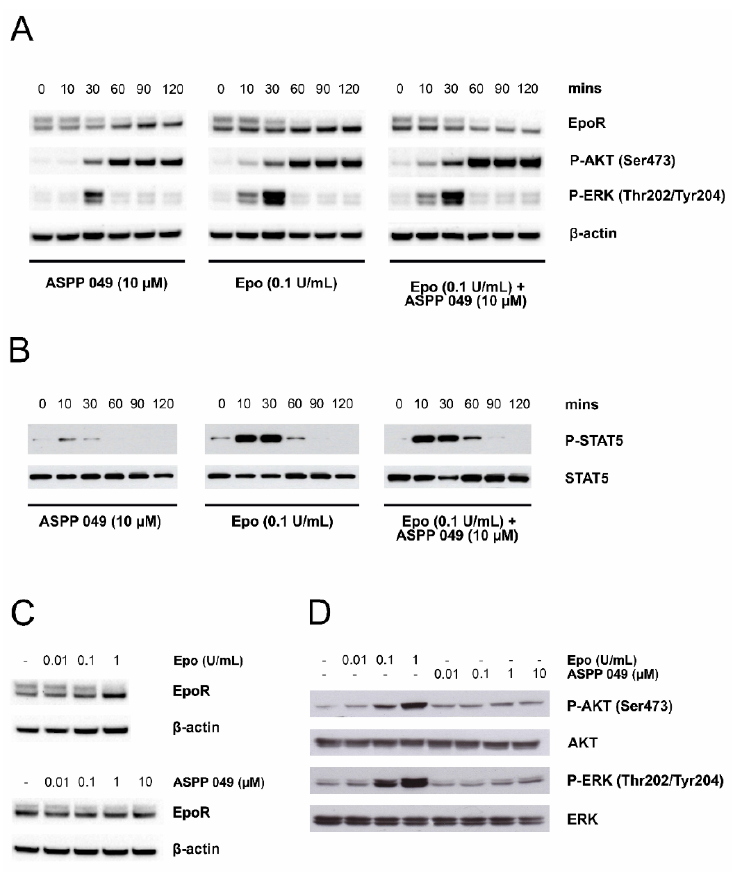
Figure 6. Stimulation of erythropoiesis by ASPP 049 involves EpoR-dependent activation of STAT5, MAPK/ERK, and PI3K/AKT pathways. ( A ) Representative blot showing time-dependent effects of ASPP 049, Epo, and ASPP 049 + Epo on protein expression of EpoR, phospho-AKT, and phospho-ERK. Serum-starved UT7/Epo cells were treated with 10 µ M ASPP 049, 0.1 U/mL Epo, or 10 µ M ASPP 049 + 0.1 U/mL Epo for different times ( 10–120 min) and harvested for immunoblotting with anti-EpoR, anti-phospho-AKT (Ser473), and anti-phospho-ERK (Thr202/Try204) antibodies. ( B ) Representative blot showing effects of ASPP 049 on phospho-STAT5 protein expression. Serum-starved UT7/Epo cells were treated with 10 µ M ASPP 049, 0.1 U/mL Epo, or a combination for different times (10–120 min) and harvested for immunoblot- ting with anti-phospho-STAT5. ( C , D ) Representative blot showing concentration-dependent effects of ASPP 049 on EpoR, phospho-AKT, and phospho-ERK protein expression. Serum-starved UT7/Epo cells were treated with Epo (0.01, 0.1, or 1 U/mL) or ASPP 049 (0.01, 0.1, 1, and 10 µ M) for 30 min and harvested for immunoblotting with anti-EpoR, anti-phospho-AKT (Ser473), and anti-phospho-ERK (Thr202/Try204). All data are representative of three independent experiments. AKT, protein kinase B; Epo, erythropoietin; EpoR, erythropoietin receptor; ERK, extracellular signal-regulated kinase; MAPK, mitogen-activated protein kinase; PI3K, phosphoinositide three